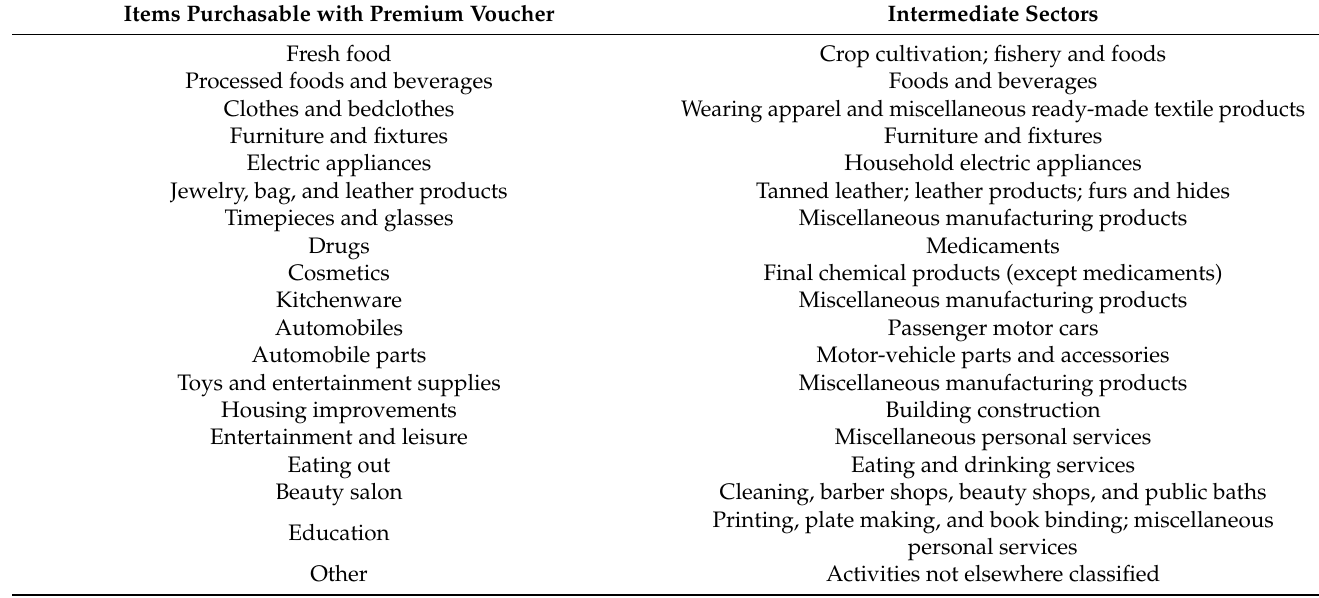
Table 3. Industrial sectors in which final demand is increased by premium